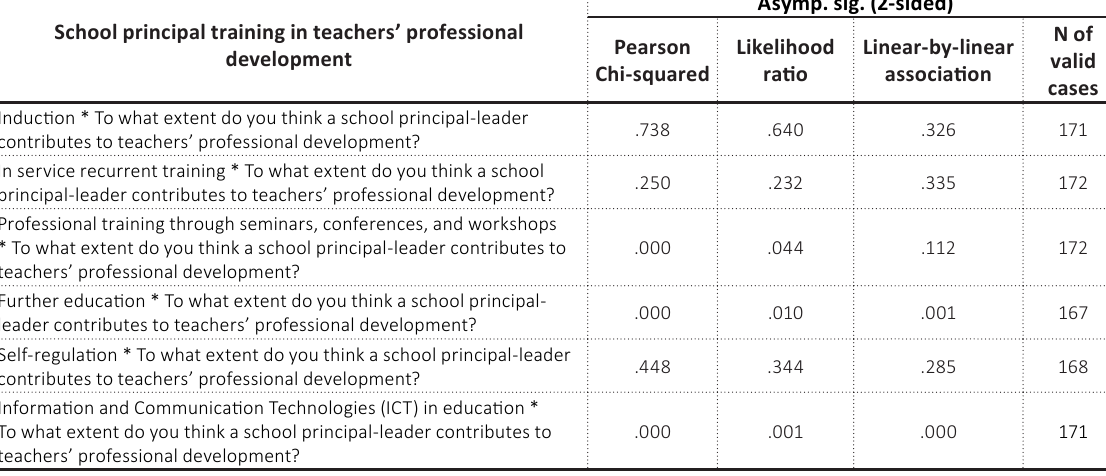
Table 6. Chi-squared analysis for hypothesis H